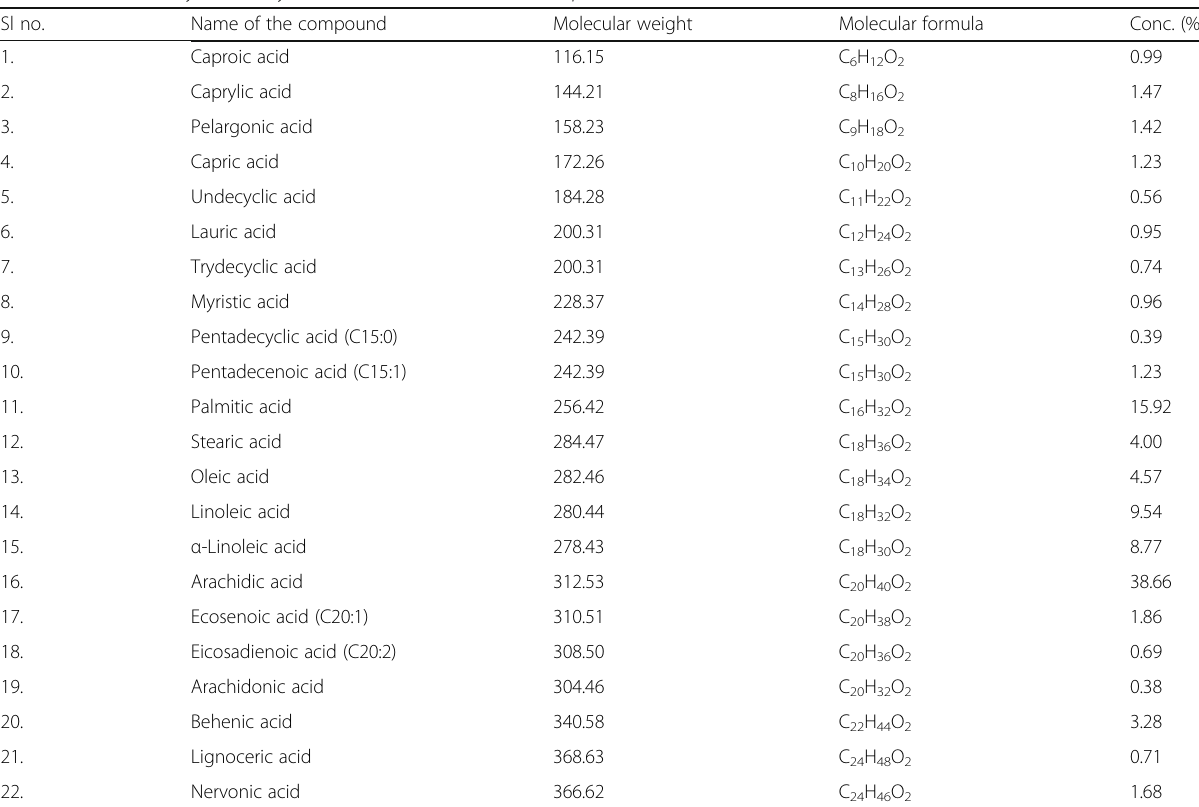
Table 2 GC-MS analysis of fatty acids of the leaves of Cassia sophera Linn Sl no.